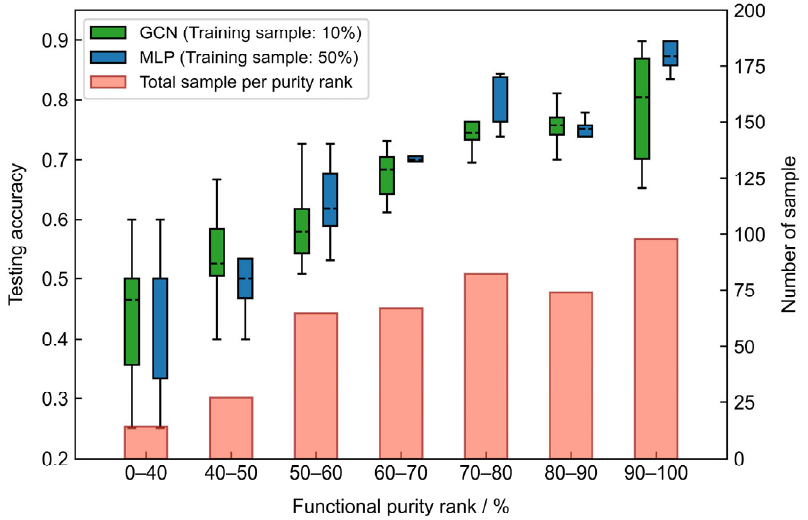
Figure 5. The correlation between accuracy and different functional purities with the frequency distribution of purity ranks.